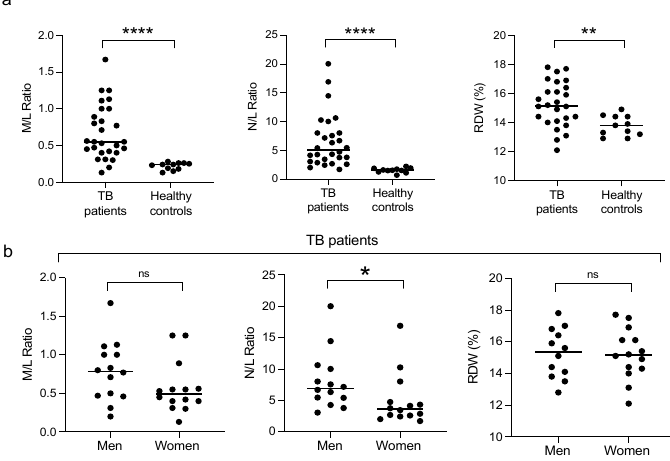
Figure 1. Hematological parameters of inflammation in pulmonary tuberculosis patients. Monocyte to lymphocyte (M/L) ratio, neutrophil to lymphocyte (N/L) ratio, and red blood cell distribution width % (RDW%) were calculated in patients and healthy controls ( a ). Data were disaggregated by sex for the patients ( b ). Individual results with medians are depicted. * p < 0.05, ** p < 0.01, **** p < 0.0001, ns = not significant.